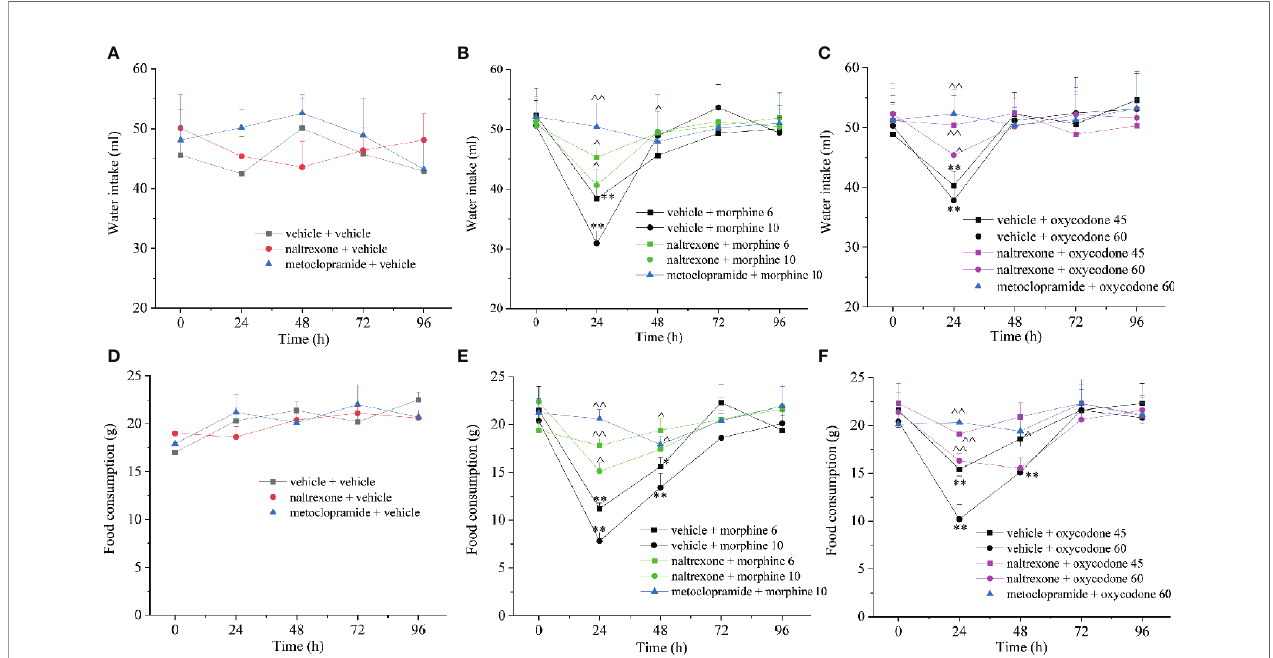
FIGURE 8 | Effect of intranasal administration of naltrexone on morphine and oxycodone reduced food and water intake in the rat. (A – C) Water and food (D – F) intake were measured up to 96 h after morphine (6 – 10 mg kg − 1 ) or oxycodone (45 – 60 mg kg − 1 ) administration. Metoclopramide (5 mg kg − 1 ) or naltrexone (1 m g) was administered 30 min before the opioids. Control animals were treated with vehicles. Each value represents the mean of 10 rats per group, performed in two different experimental sets. *P < 0.05 and **P < 0.01 vs vehicle-treated animals; ^P < 0.05 and ^^P < 0.01 vs morphine or oxycodone-treated animals.